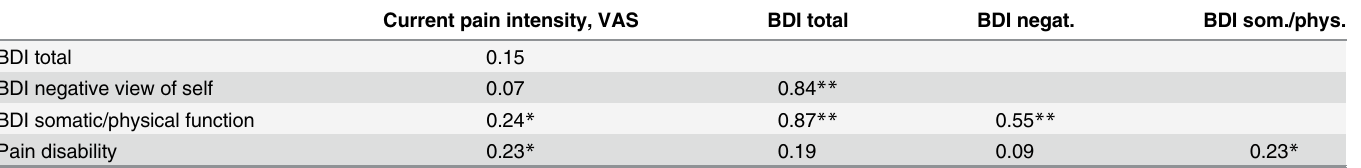
Table 2. Pearson`s zero-order correlation coefficients for pain intensity and psychological variables.